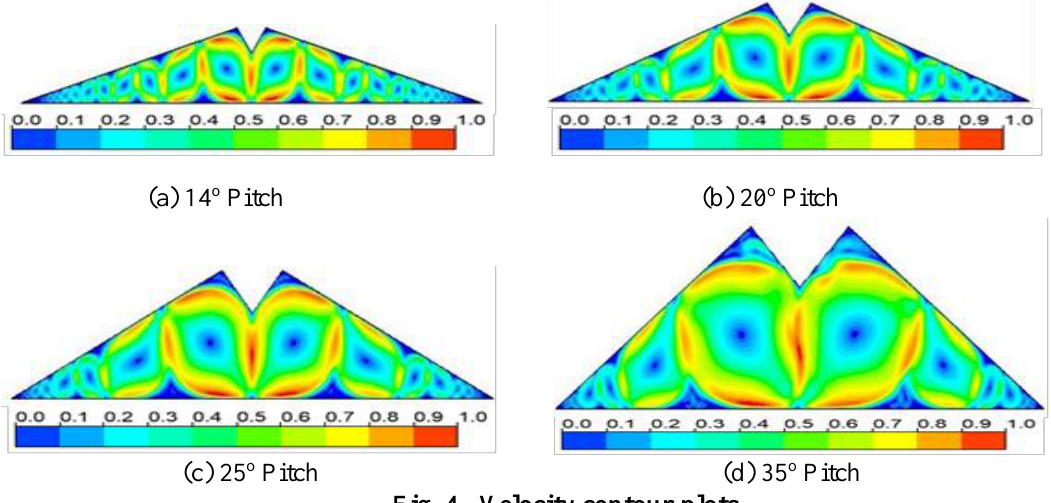
Fig. 4. Velocity contour